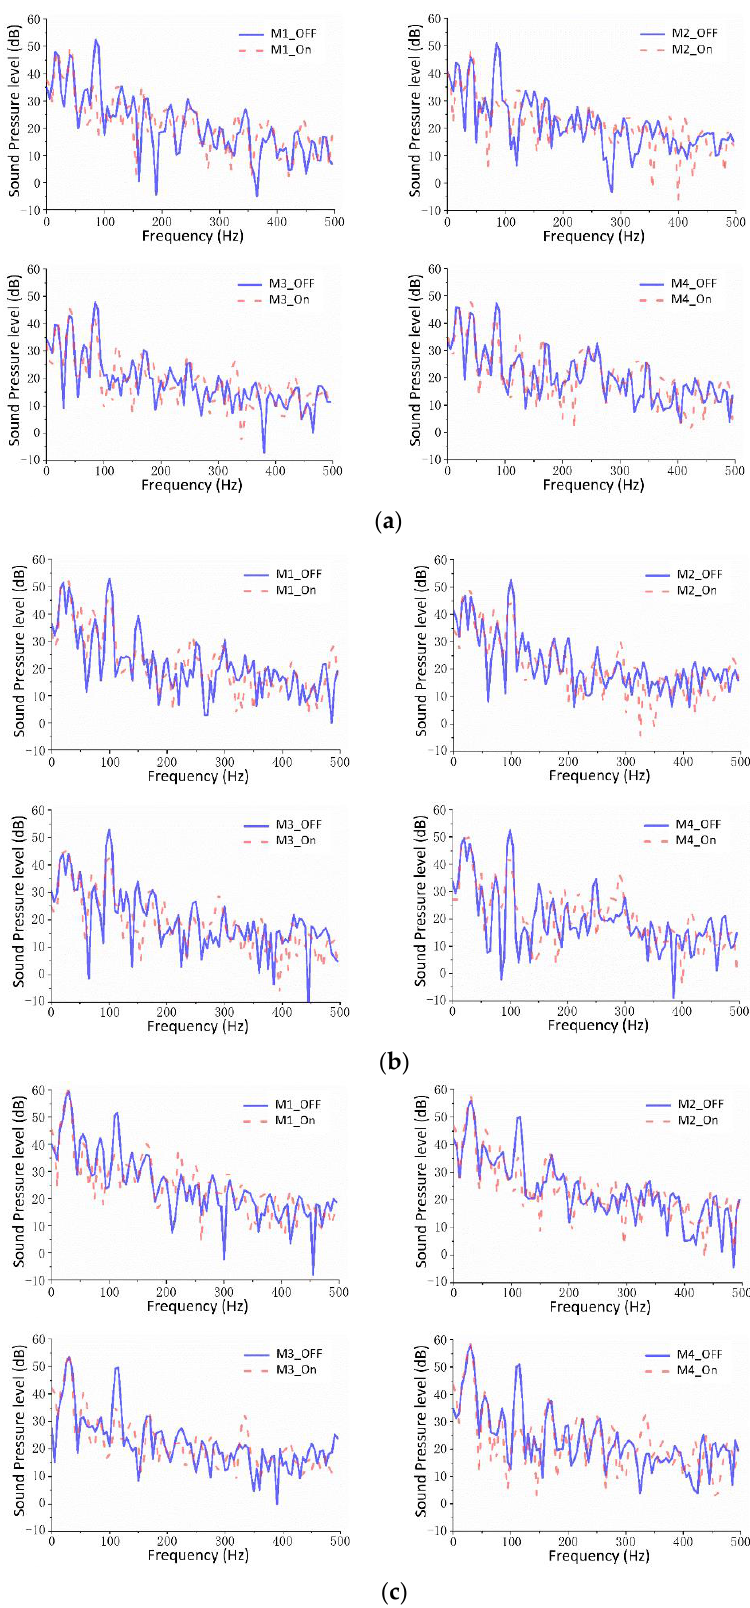
Figure 13. Noise spectrum diagrams before and after noise control of vehicle engine noise at different speeds: ( a ) Spectrum before and after active noise control (ANC) at 2500 r/min; ( b ) Spectrum before and after ANC at 3000 r/min; ( c ) spectrum before and after ANC at 3500 r/min. As shown in Figure 13, because the vehicle engine noise changed with the speed, corresponding to a certain frequency, after the multi ‐ channel fractional ‐ order ANC algo- rithm was turned on, the amplitude at the peak frequency of the engine noise was signif- icantly reduced by more than 10 dB, and the total noise cancellation was reduced by ap- proximately 4.7 dB on average (Table 4). Most of the noise below 50 Hz was generated by the resonance of the vehicle body structure and should be optimized from the per- spective of vibration reduction. Overall, it was demonstrated that the multi ‐ channel frac- tional ‐ order ANC algorithm is capable of effectively reducing the engine noise in the target area and expanding the silent zone. 4. Conclusions The multi ‐ channel fractional ‐ order ANC algorithm was proposed in this study with the use of fractional ‐ order calculus, multiple input and output feedback, and variable time steps for convergence. The experimental results showed that the proposed algo-